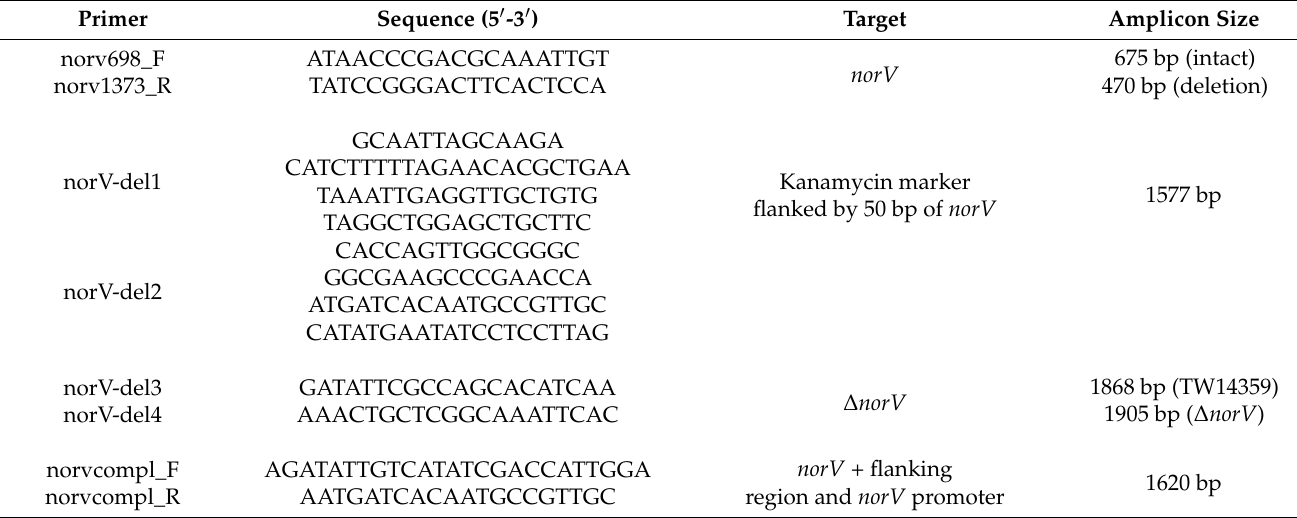
Table 1. Oligonucleotide primers developed for use in this